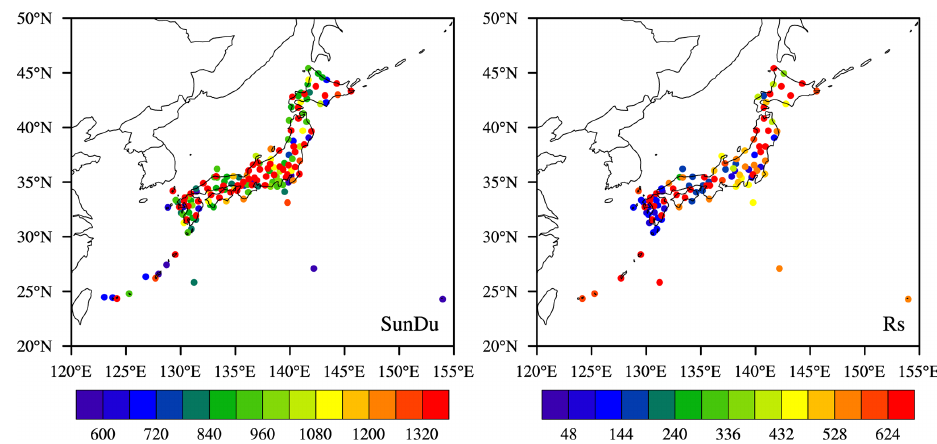
Figure 1. The spatial distribution of stations over Japan with observed sunshine duration (SunDu, 156 stations) and surface incident solar radiation ( R s , 105 stations) data. The colours indicate the data length of the SunDu records from 1890 to 2015 and R s records from 1961 to 2015. Unit: month.